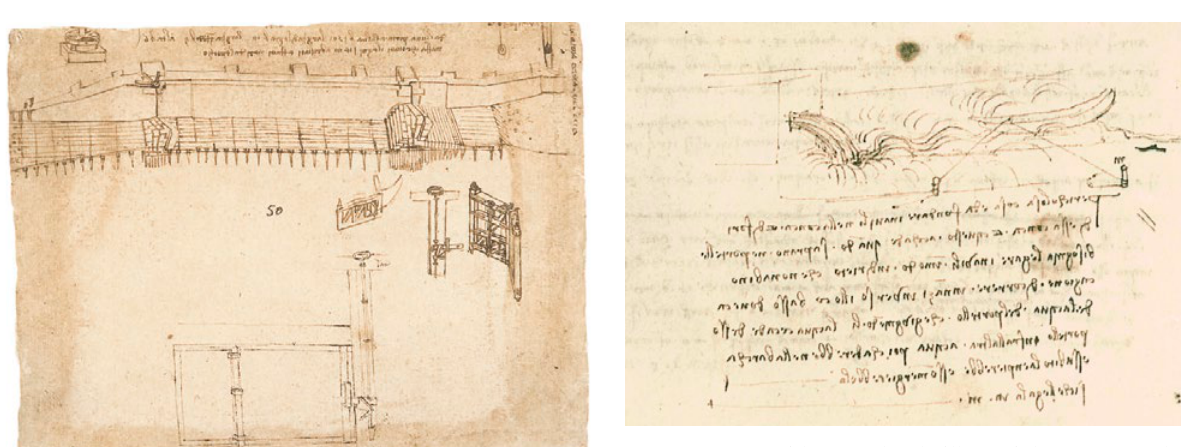
Figure 14. C.A., fol. 127v, detail: filling of the navigation basin through the door of the